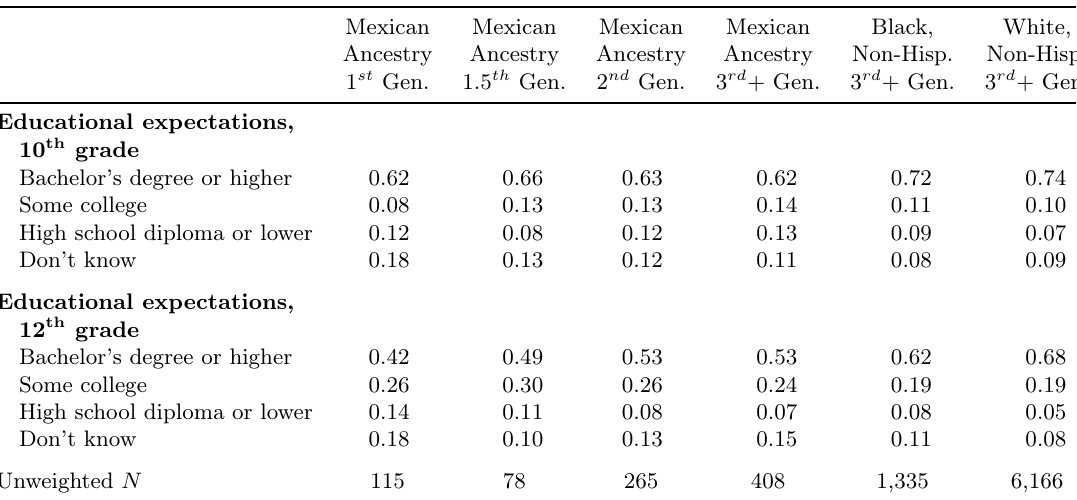
Table 6: Educational Expectations for the Six Focal